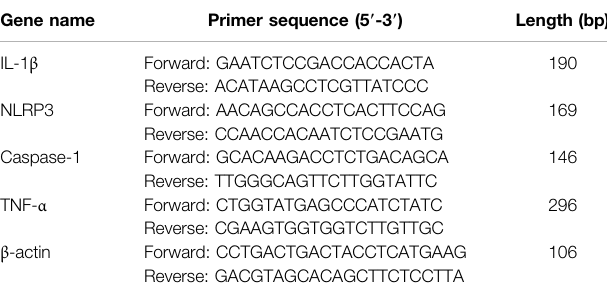
TABLE 1 | The speci fi c primers used in RT-PCR assay